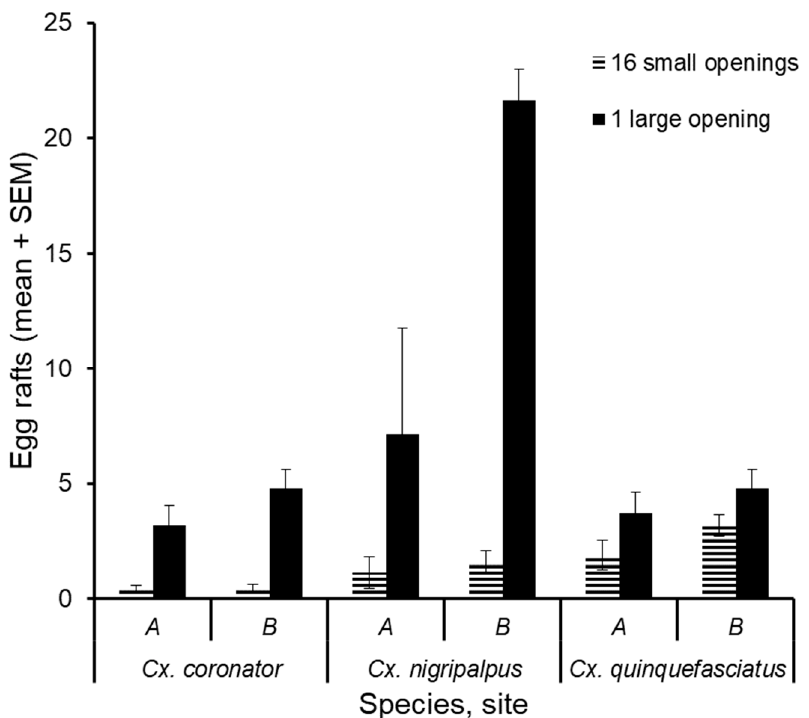
Figure 3. Average number of egg rafts deposited by three Culex species in containers with two cover types, at sites A and B. Covers had 16 small openings or one large opening of equivalent total opening area. Bars represent standard error of the mean.